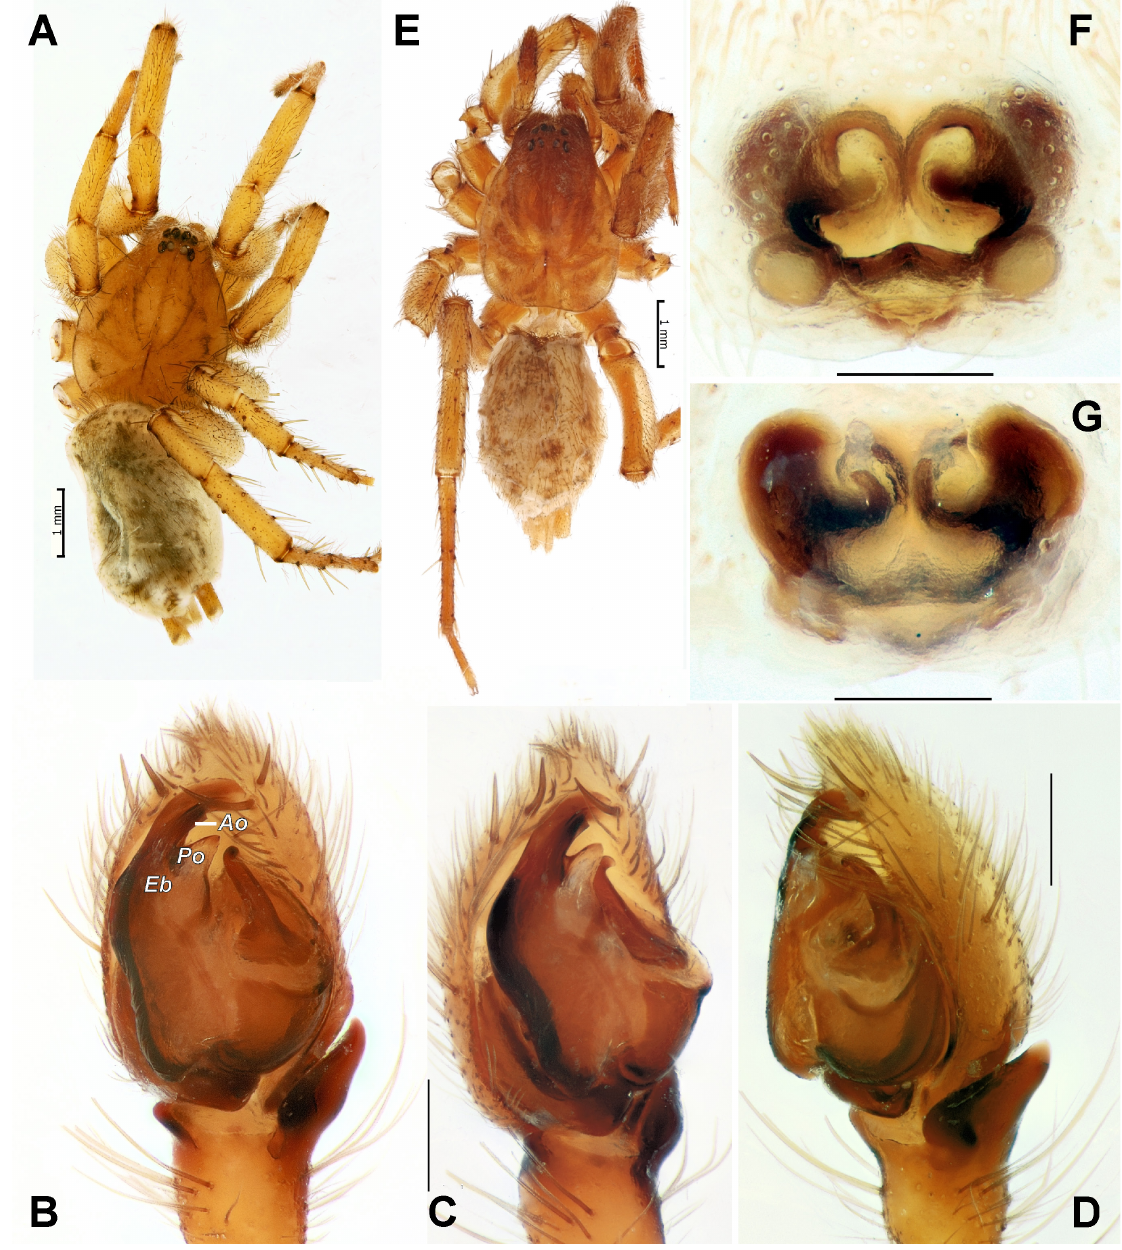
Fig. 3. A–D . Berlandina artaxerxes sp. nov., holotype, ♂ (SMF). A . Habitus, dorsal view. B–D . Palp, ventral, proventral and retrolateral views. – E–G . Berlandina mesopotamica Al-Khazali, 2020, ♀ (MHNG). E . Habitus, dorsal view. F–G . Epigyne, ventral and dorsal views. Abbreviations: Ao = apical outgrowth; Eb = embolar base; Po = pointed process. Scale bars: 0.2 mm, unless stated